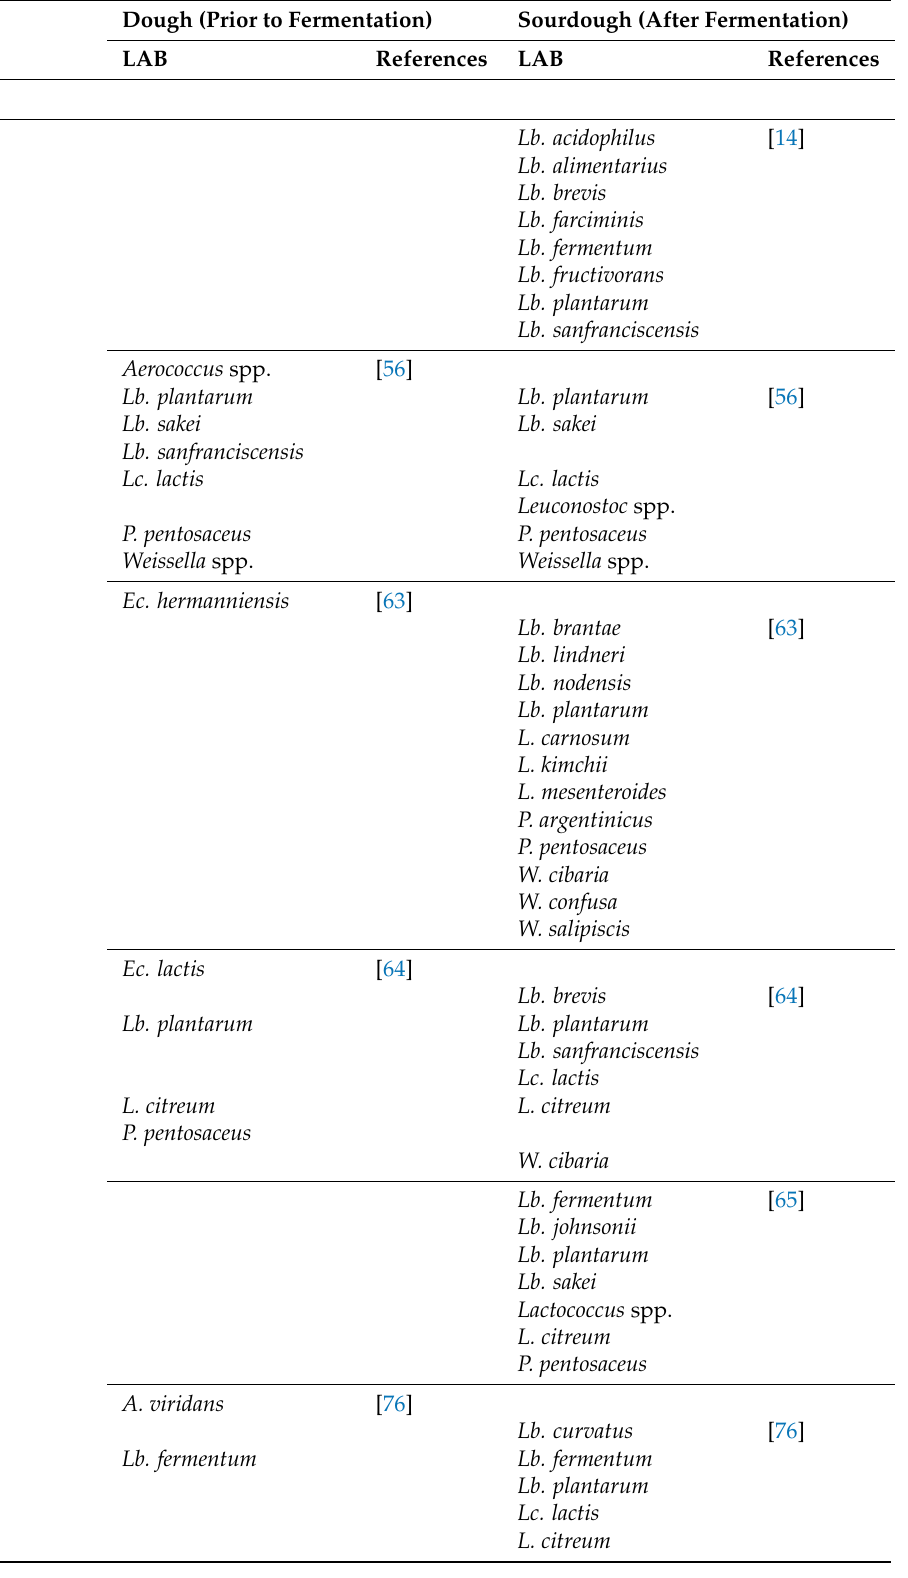
Table 2. Summary of lactic acid bacteria (LAB) isolated from sourdough using different types of